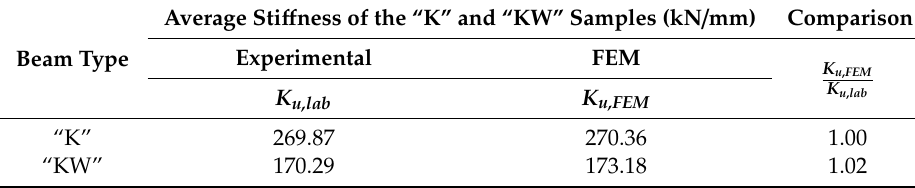
Figure 16. Comparison between the finite element method (FEM) and the laboratory results. Table 1. Comparison of the sti ff ness of the “K” and “KW”